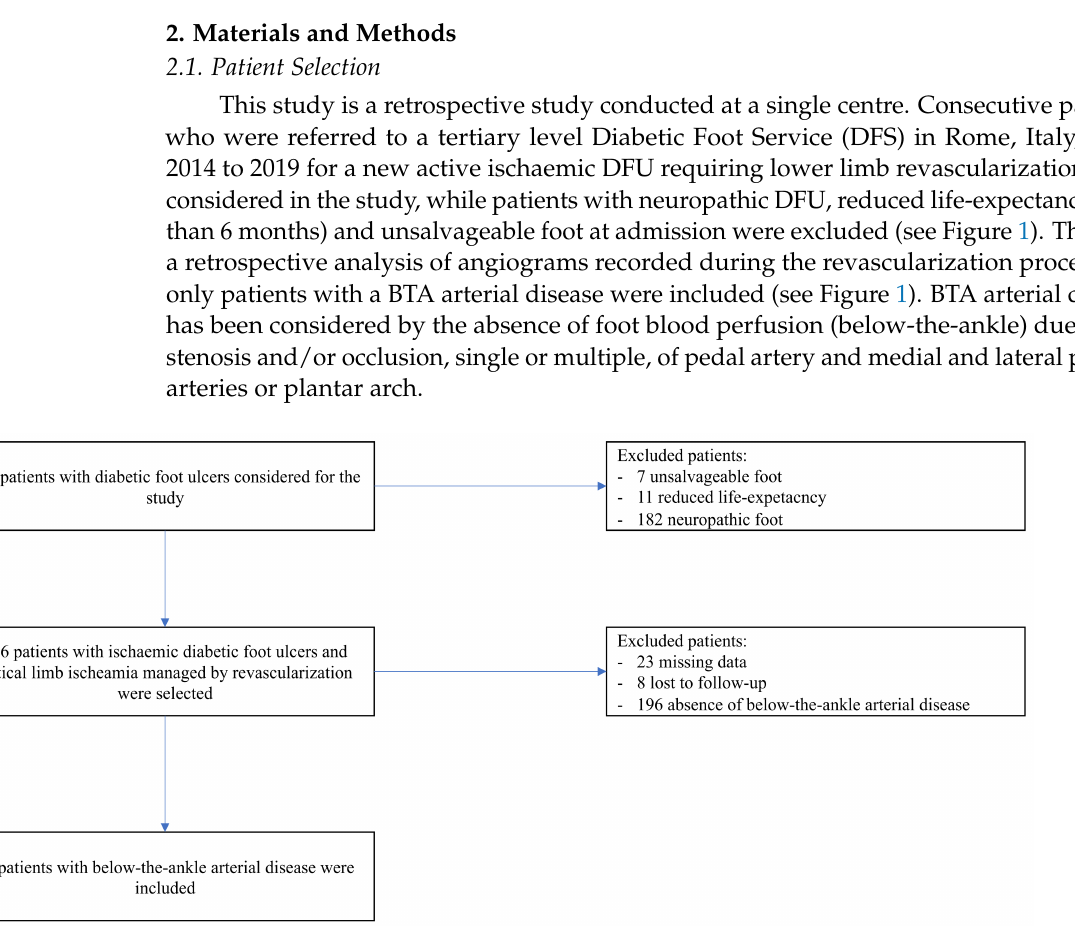
Figure 1. Flow-chart on patient’s recruitment and inclusion in the